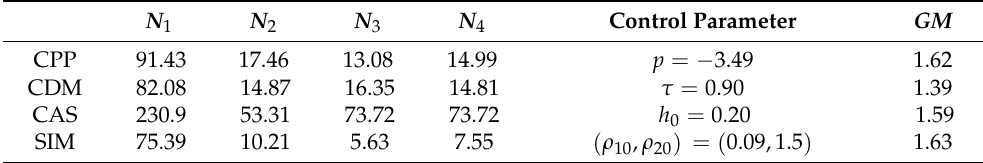
Table 2. State-feedback controller gains and associated parameters.